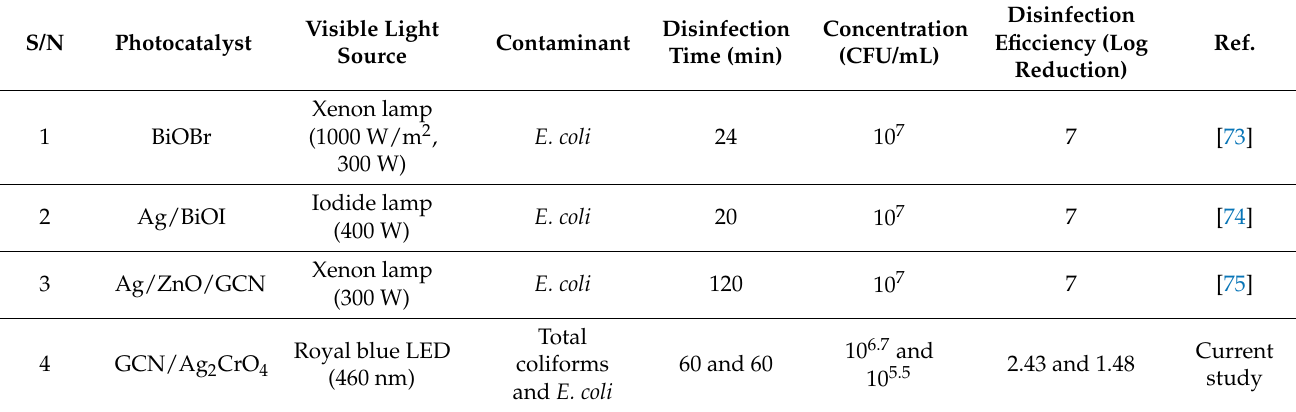
Table 4. Comparison of microorganim disinfection with the results of previously published